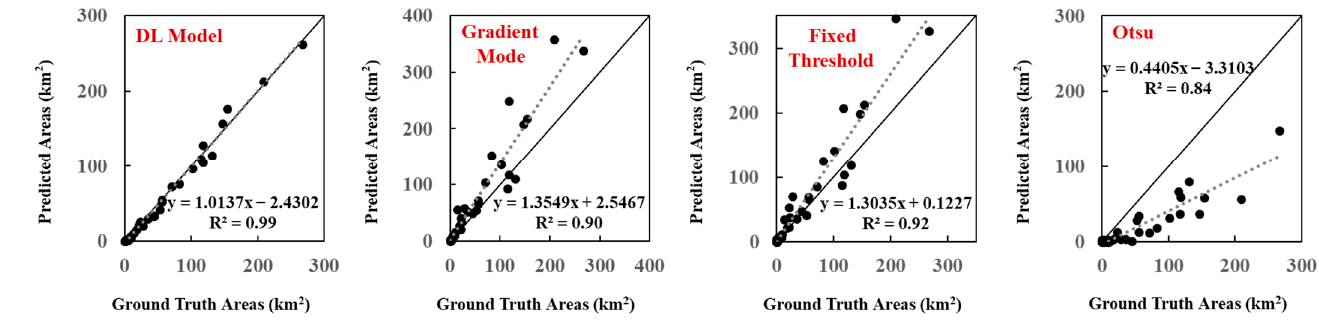
Figure 10. Scatter plots of the CyanoHABs area predicted by four different methods with comparison to ground truth.